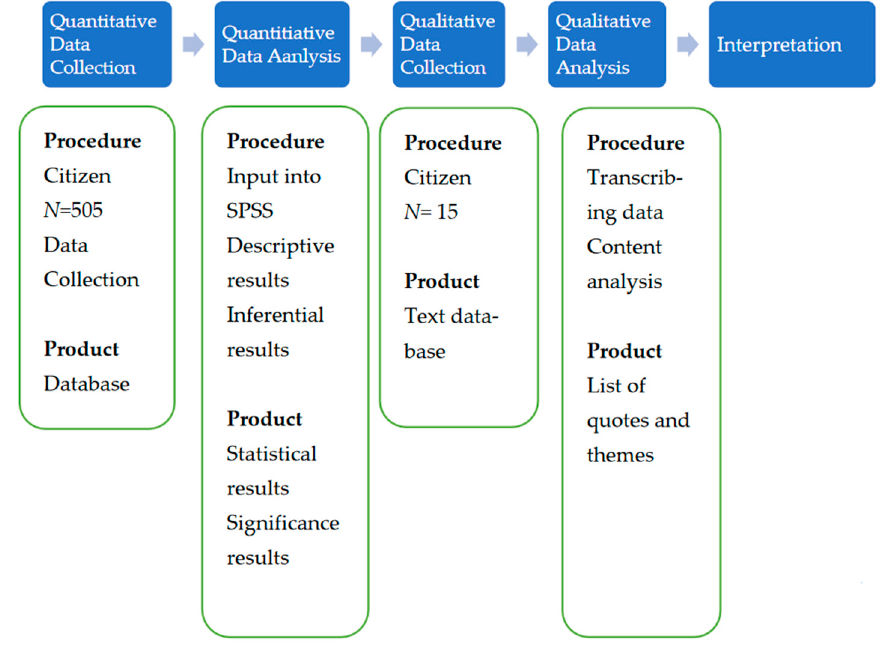
Figure 4. A sequential mixed-method research design adapted from Creswell (J. W. Creswell 2015).